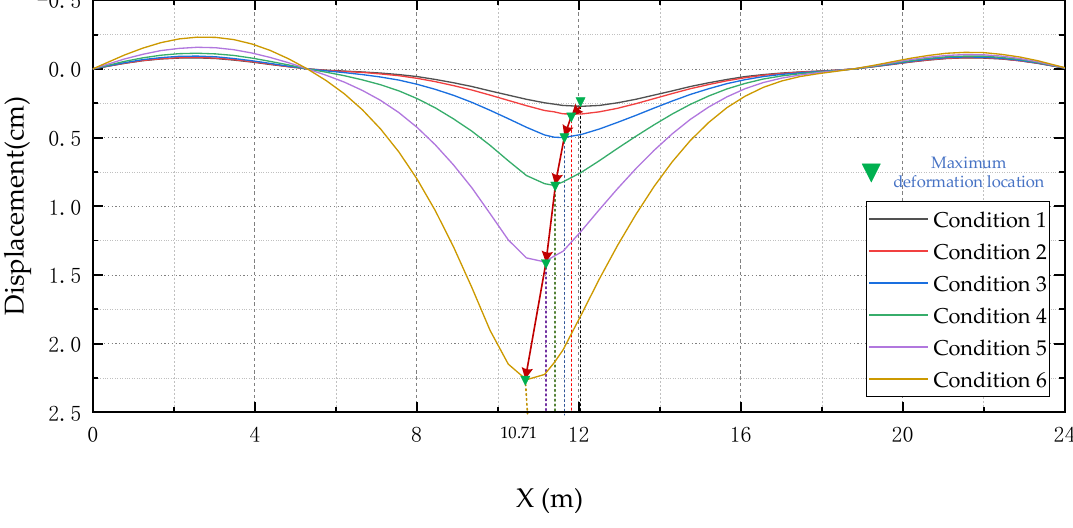
Figure 20. Deformation trend chart.